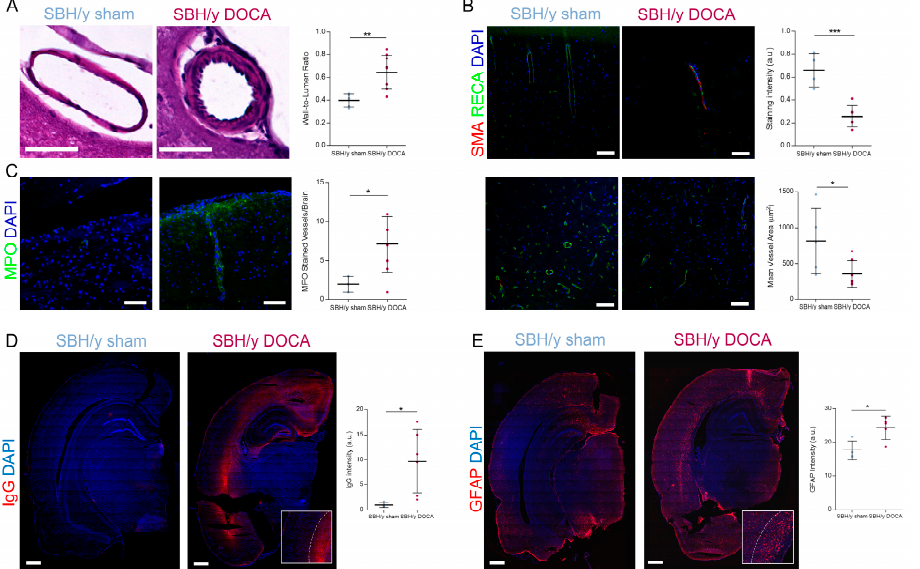
Figure 4. Vascular pathology and BBB permeability in SBH/y-DOCA brains. Representative H&E images and wall-to-lumen ration (WLR) quantification ( A ) of pial blood vessels of SBH/y sham ( n = 5) and SBH/y-DOCA ( n = 9) rats. α SMA and RECA-1 co-immunostaining of parenchymal blood vessels ( B ) and quantification of mean staining intensity (top right) and mean vessel area (bottom right) in SBH/y sham ( n = 4) and SBH/y-DOCA ( n = 7) brains. Representative images and quantification ( C ) of parenchymal blood vessels staining for MPO in the brains of SBH/y sham (left, n = 4) and SBH/y-DOCA (right, n = 6) rats. IgG staining and quantification ( D ) and GFAP immunostaining and quantification ( E ) of SBH/y sham ( n = 4) and SBH/y-DOCA ( n = 6) brains. Insets in ( D , E ) show a magnification outlining the corpus callosum border. Scale bars in ( A – C ) = 75 µ m. Scale bars in ( D , E ) = 3 mm. Data are presented as mean ± SD. * p < 0.05, ** p < 0.01, *** p < 0.001, two-tailed t